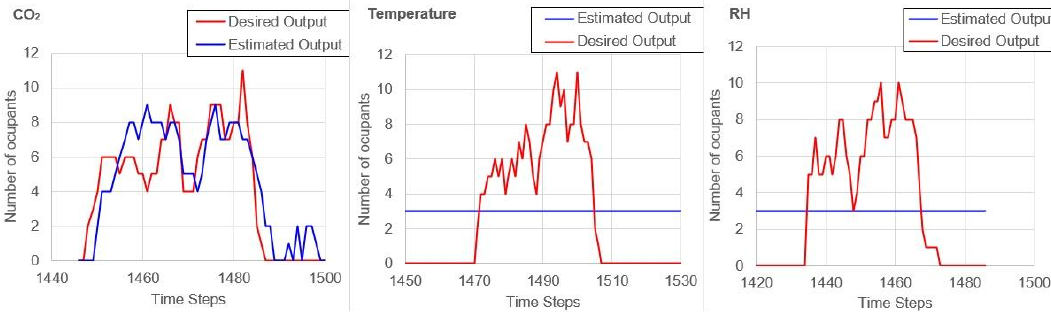
Figure 15. OSELM with DE modelling results for one day for each of the indoor parameters.